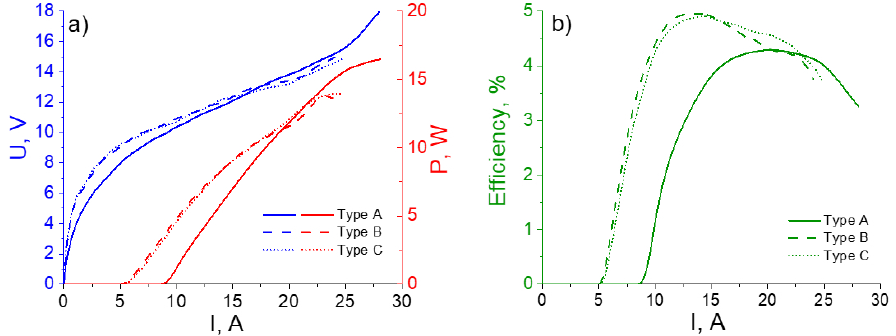
Figure 5. The L(I) and V(I) ( a ) and efficiency ( b ) curves measured for the 60 µ m QCL